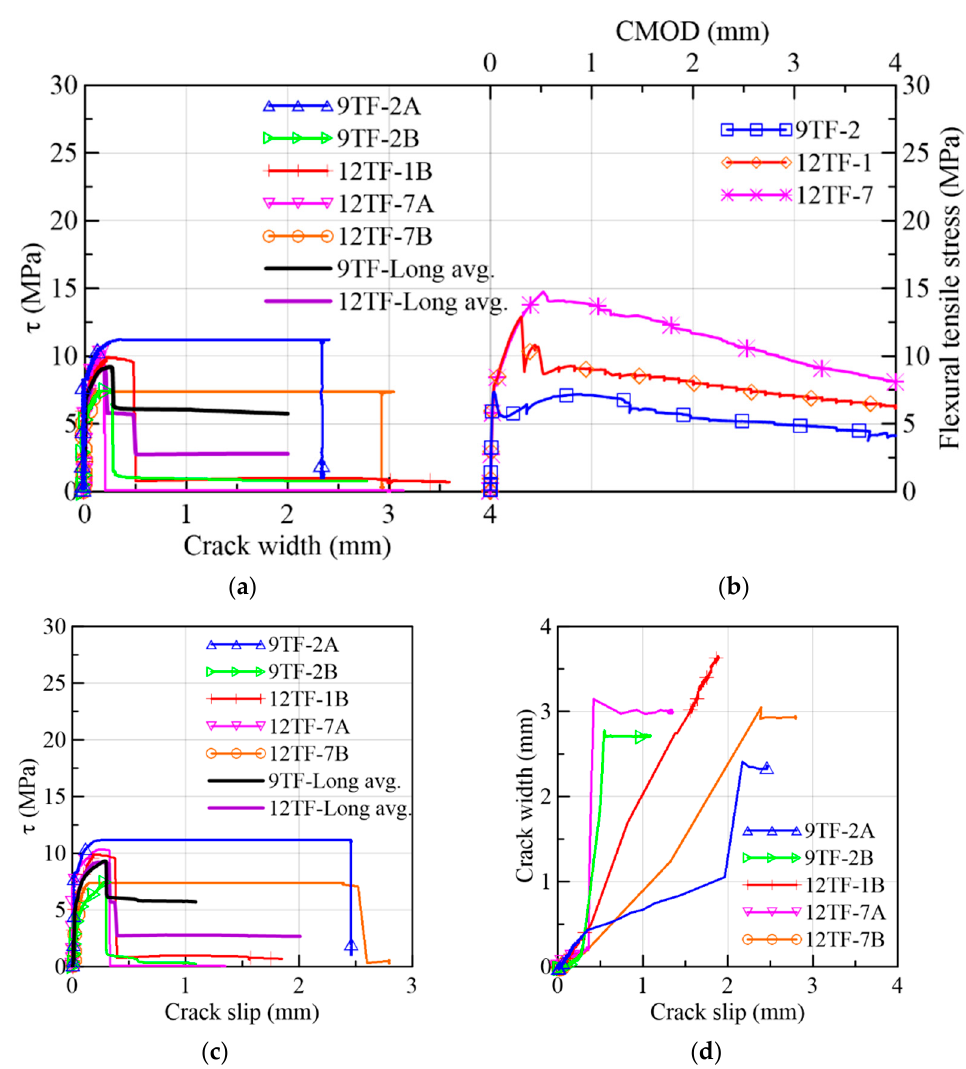
Figure 20. Fiber orientation in the top flanges of the R/SFRC box girder prototype.